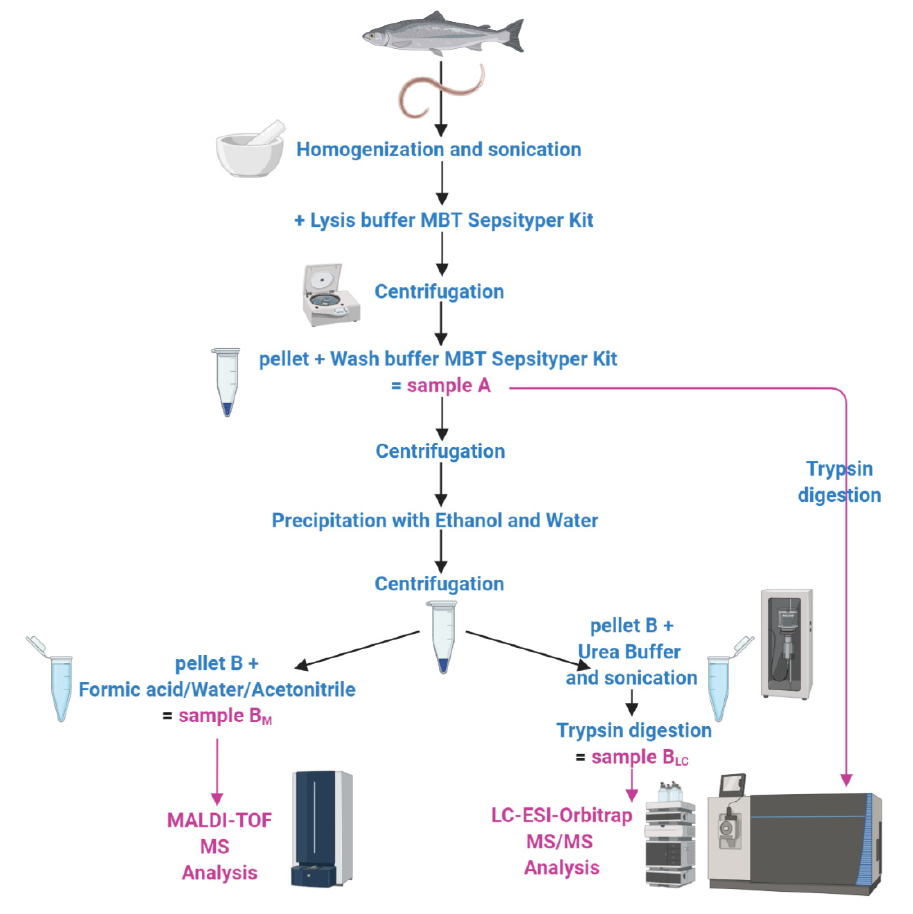
Figure 1. Sketch of the two proteomic experimental approaches exploited for Anisakis spp.